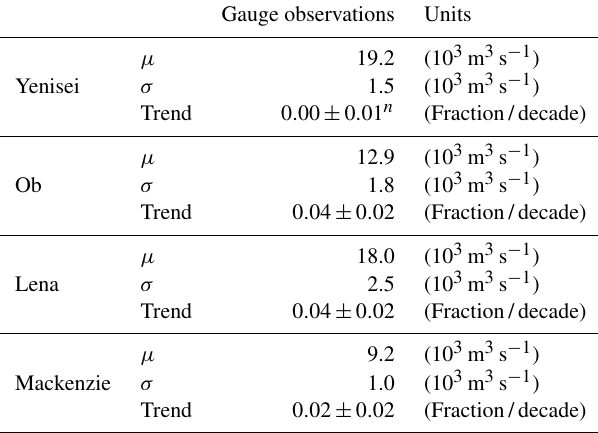
Table 4. Mean values and standard deviations of observed river dis- charge as well as relative decadal trends and their standard errors (see Eq. 10), calculated over the period 1981–2019. Trends that are not significant are marked with a superscript n